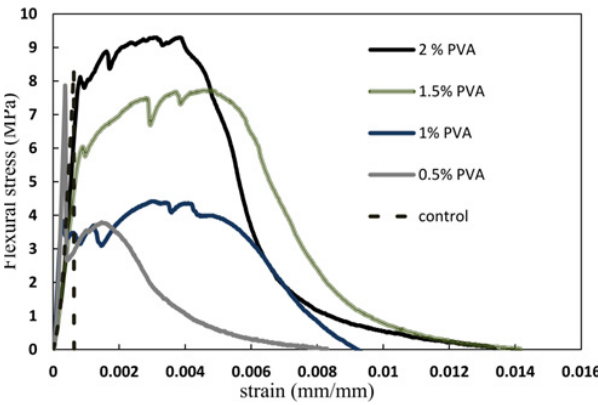
Fig. 7. Stress-strain curve of ECC containing PVA